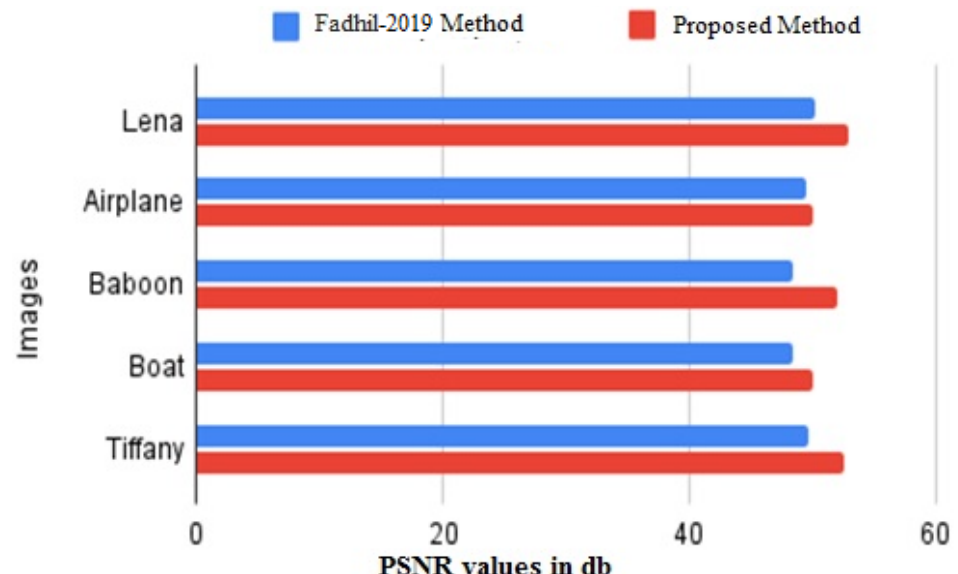
Figure 9. PSNR values (db) Comparison between Fadhil et al. [40] vs. proposed scheme on five gray-scale images.